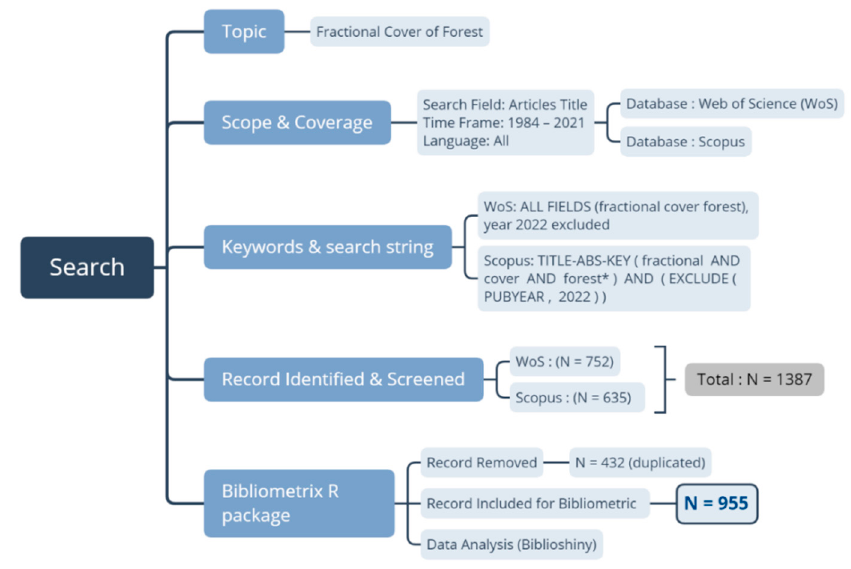
Figure 1. Flow diagram of the publications searching methodology.